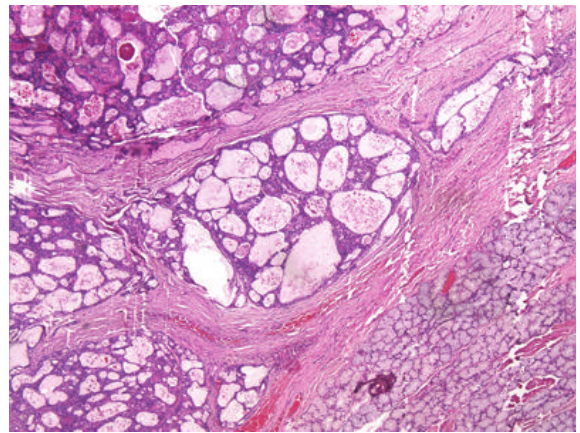
Figure 3: Microphotograph (H & E stain, × 200) showing epithelial and mesenchymal elements suggestive of pleomorphic adenoma.